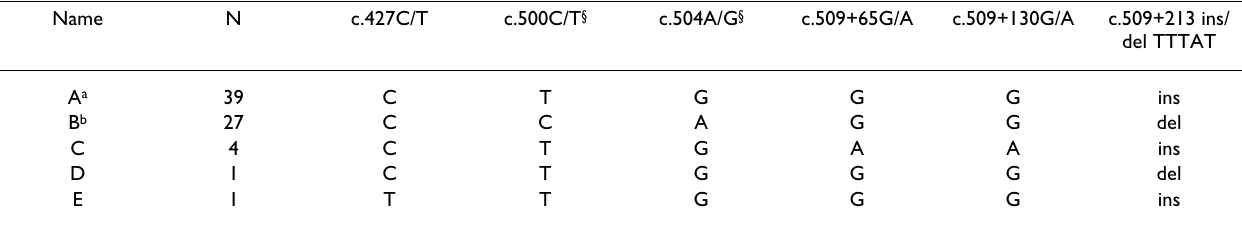
Table 1: HA-1 haplotypes found in 72 random chromosomes of the Italian